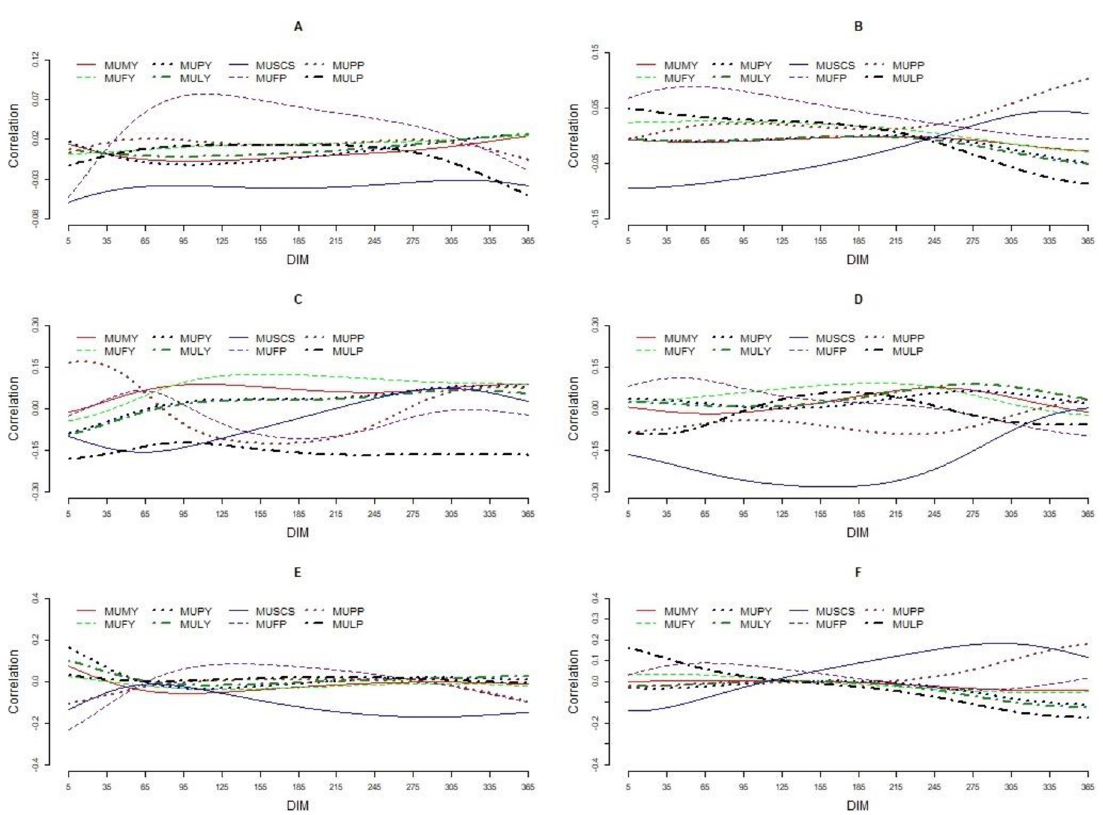
Fig 3. Correlation estimated in daily basis between MU and productive traits included in primiparous and multiparous cows within DIM. Phenotypic correlation in primiparous (A) and multiparous (B), permanent environmental correlation in primiparous (C) and multiparous (D), genetic correlation in primiparous (E) and multiparous (F)